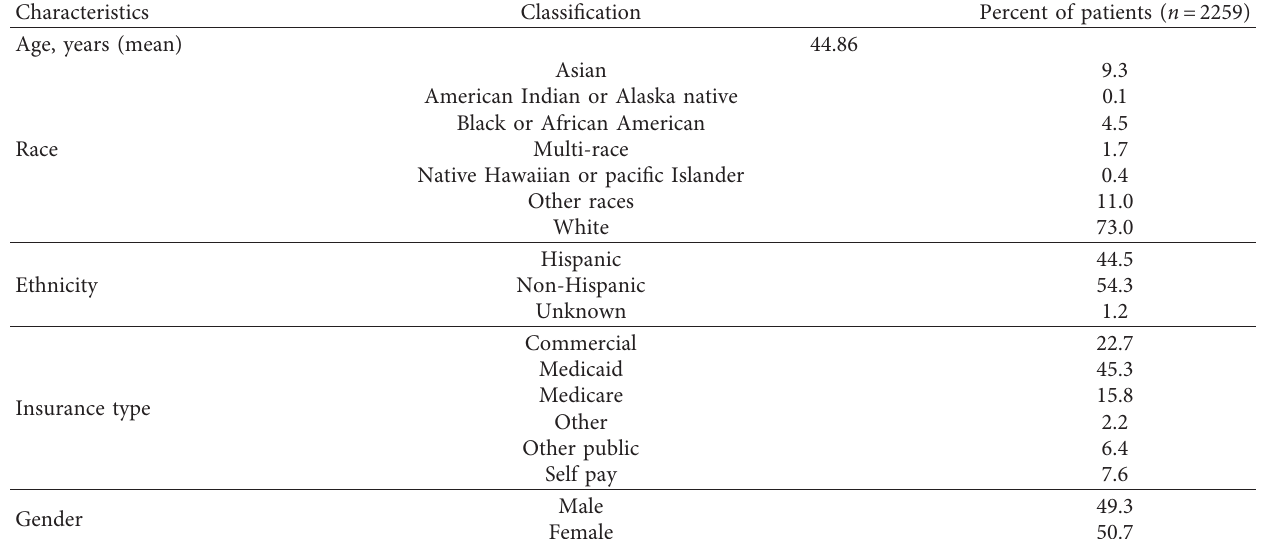
Table 1: Baseline characteristics.